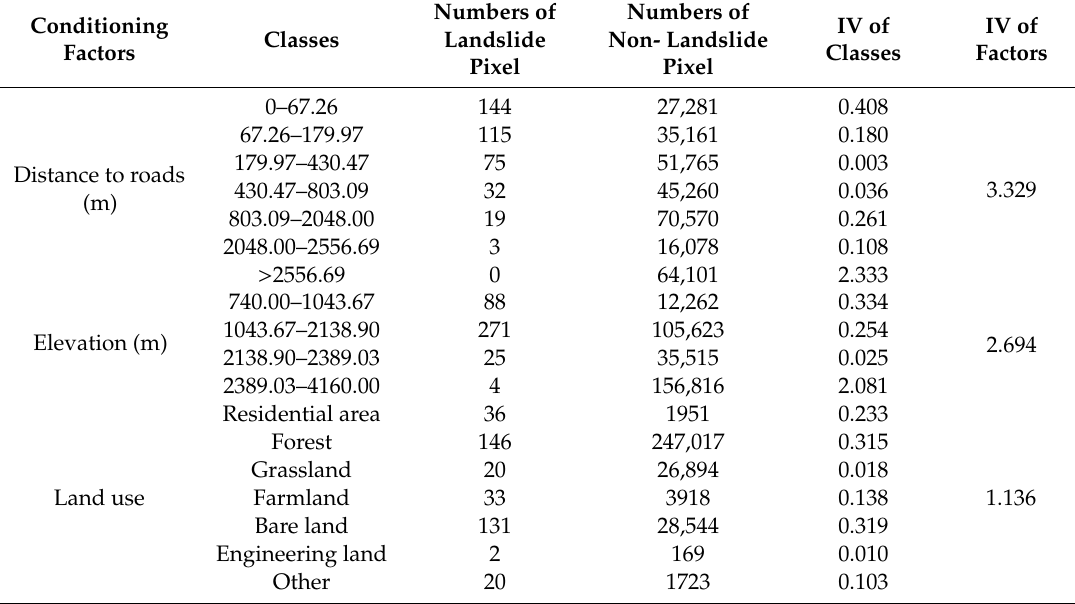
Table 2. Information value (IV) analysis of landslide conditioning